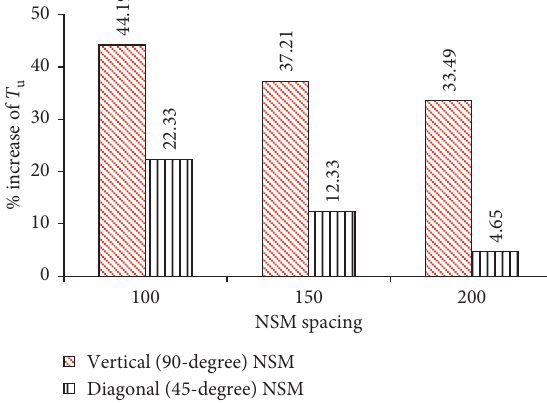
Figure 13: Influence of NSM alignments on T